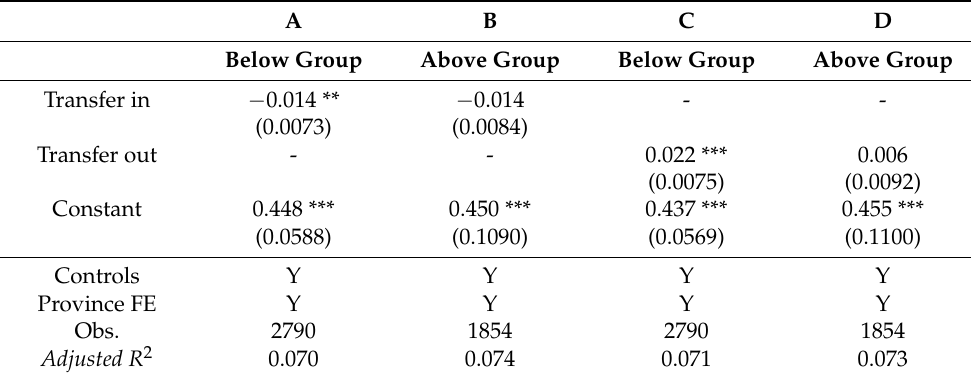
Table 7. Heterogeneous effects of household